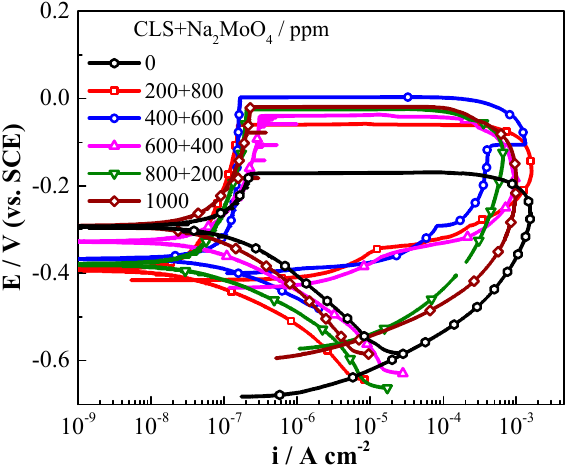
Figure 3. Polarization curves in solutions with different ratios of CLS and Na 2 MoO 4 .